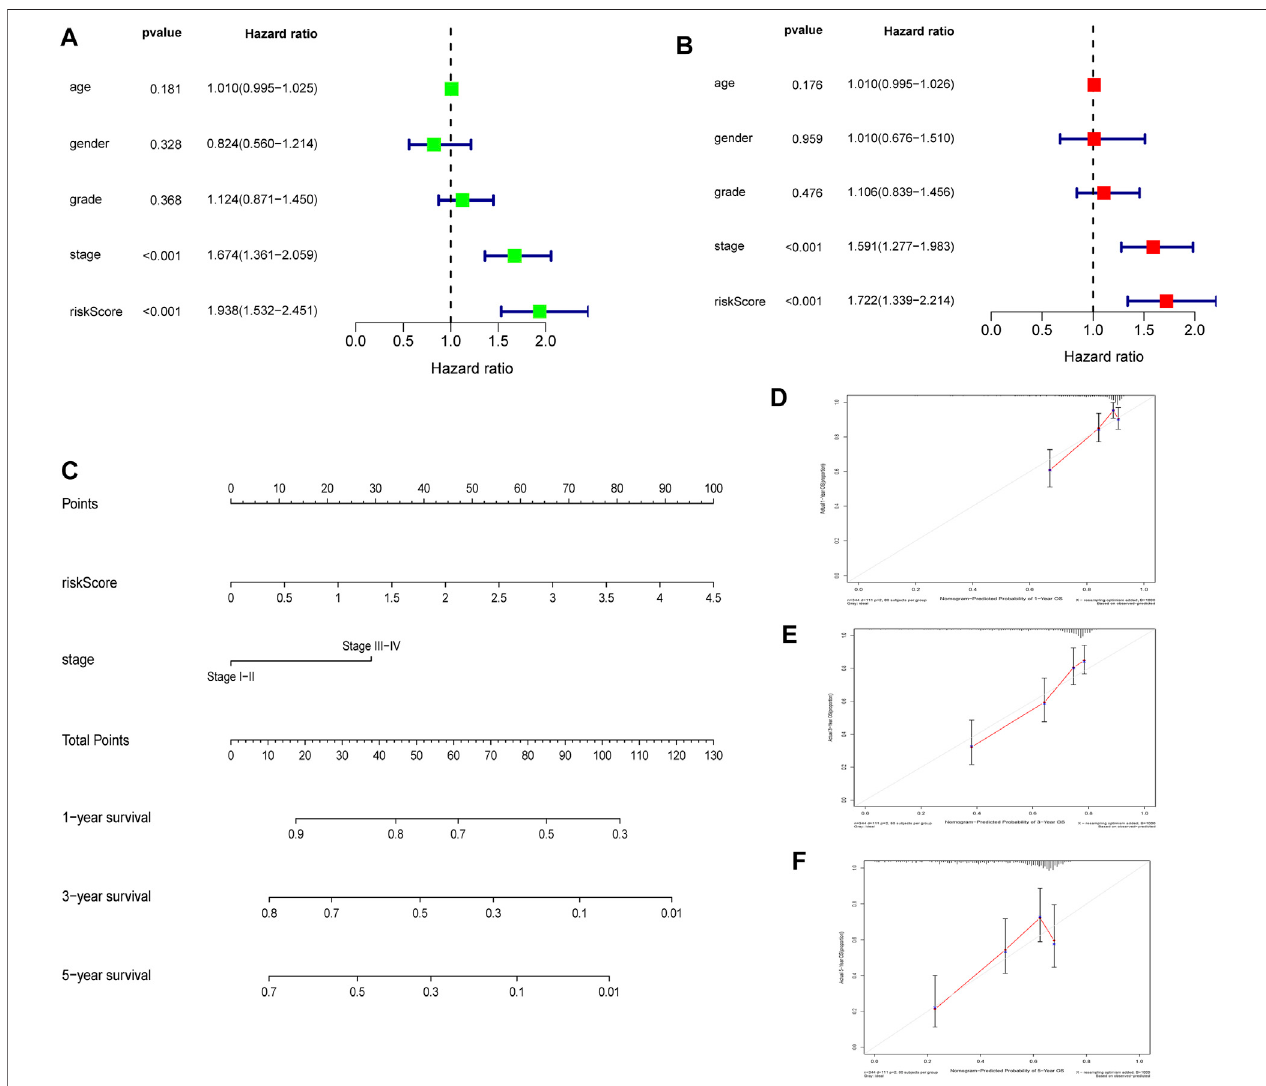
FIGURE 9 | Establishment and quality evaluation of a nomogram in TCGA cohort (A) . Univariate analysis of risk score and clinicopathological features (B) . Multivariate analysis of risk score and clinicopathological features (C) . A nomogram for predicting 1-year, 3-years, and 5-years OS (D – F) . The calibration curves for predicting 1-year, 3-years, and 5-years